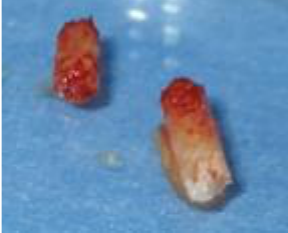
Figure 11. Bone carrots.